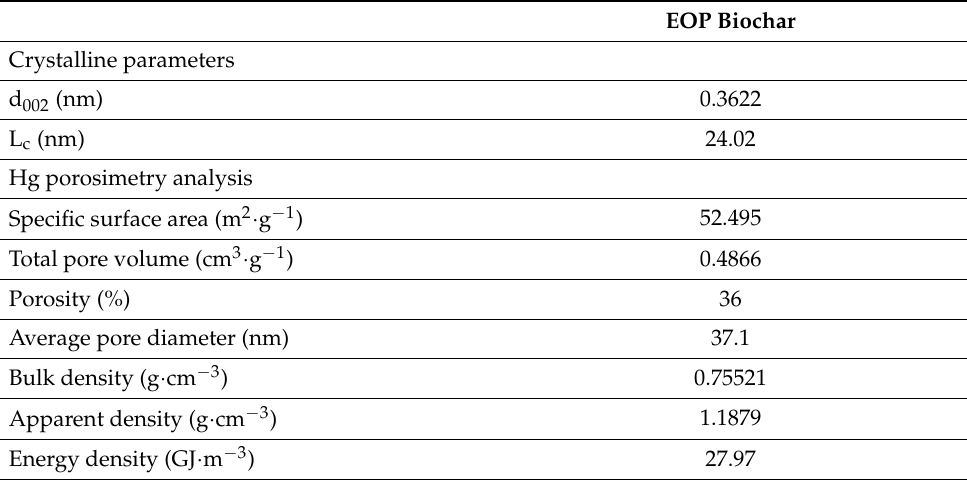
Table 3. Summarized properties of the EOP biochar